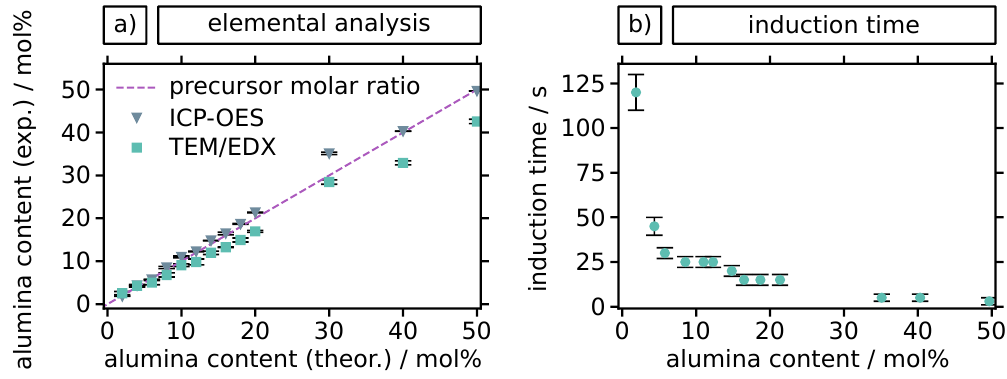
Figure 3. ( a ) Elemental analysis of zirconia particles with varying (theoretical) alumina content based on the molar composition of precursors. Zr and Al elemental fractions were quantified by TEM/EDX and ICP-OES. EDX results are based on two to four individual particles per sample, OES results are averaged over a large number of particles. Error bars indicate the standard deviation of multiple measurements. ( b ) Induction times measured during the syntheses of particles with varying alumina content (as determined by ICP-OES). The induction time decreases strongly with increasing alumina content in the range of 2 to 8 mol%. Error bars indicate the estimated uncertainty of the determination of the end of